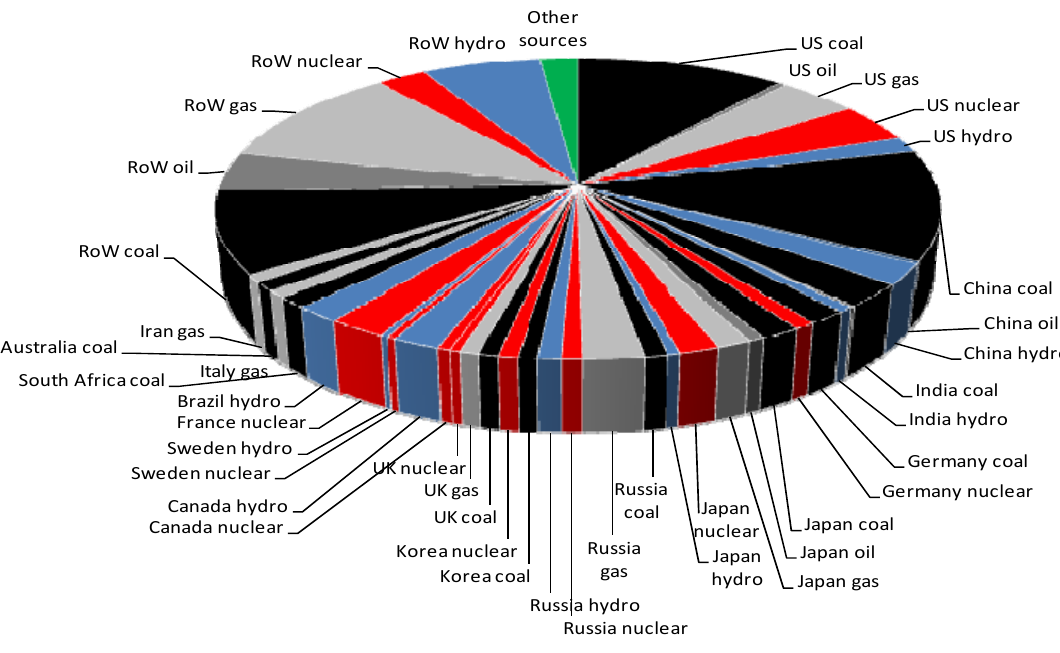
Figure 2. 2006 regional and fuel split of world electricity generation (compiled from data in